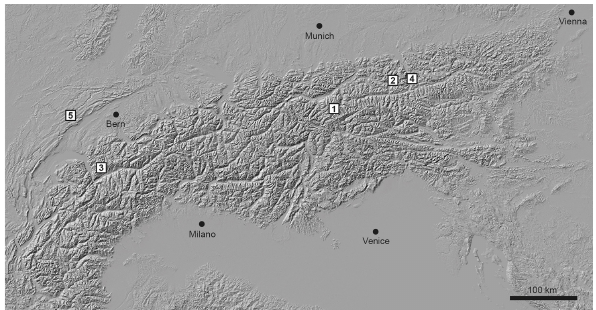
Figure 1. Elevation map of the Alps showing the currently known locations of CCC coarse (1: MSK Cave (this study); 2: Glaseis Cave; 3: Leclanché Cave) and CCC fine (4: Eisriesenwelt; 5: Monlesi Cave; as well as also in Leclanché Cave, no. 3).